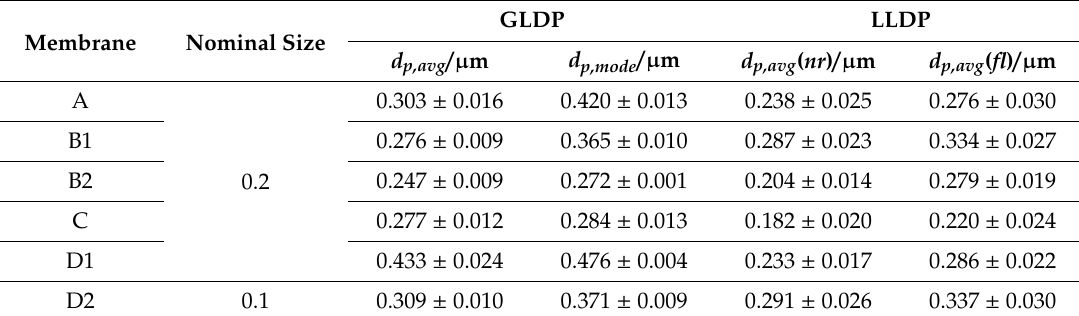
Figure 5. Example of an LLDP porosimetric pore size distribution (PSD) in terms of pore number for the C cartridge. Table 2. Results of the characterization by GLDP and LLDP of the six membrane filter cartridges